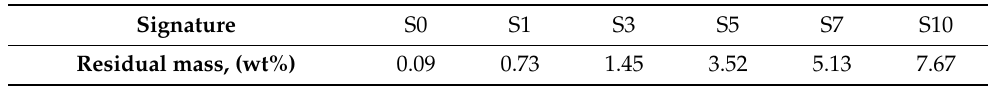
Table 4. Results of TG